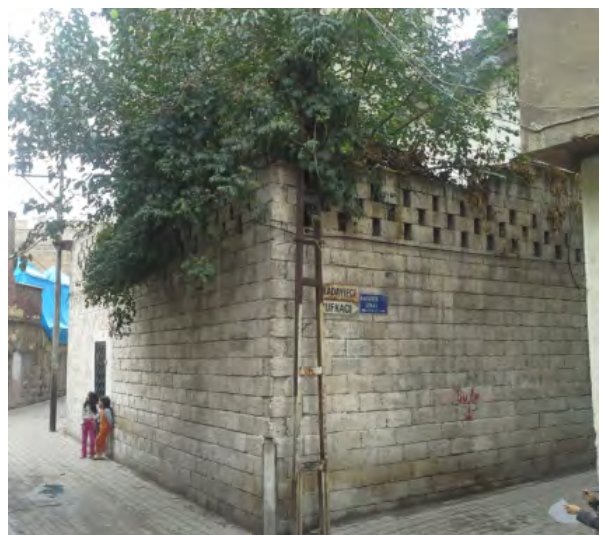
Figure 15. Courtyard Wall (Tas¸tan,2014)